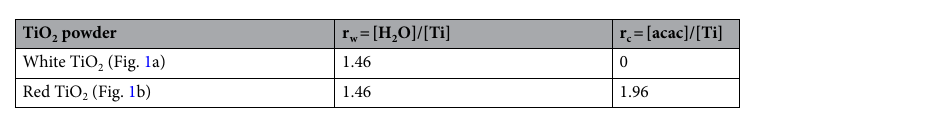
+ acacH → Ti (cid:31) OBu n (cid:30) 4